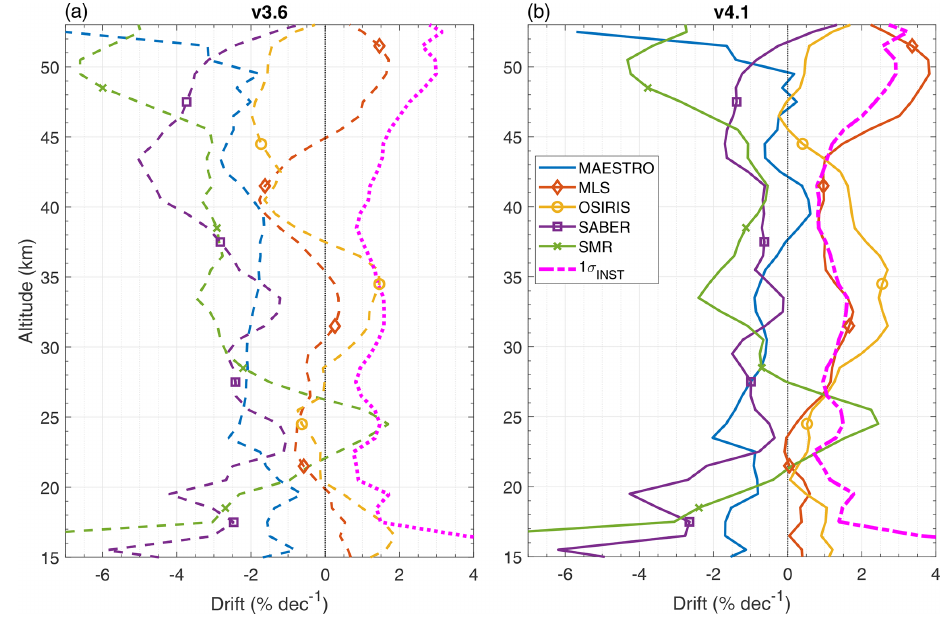
Figure 5. Relative drift profiles for each INST relative to ACE-FTS v3.6 (a) and v4.1 (b) and the corresponding inter-instrument stability (magenta), represented by the standard deviation of the drift profiles.